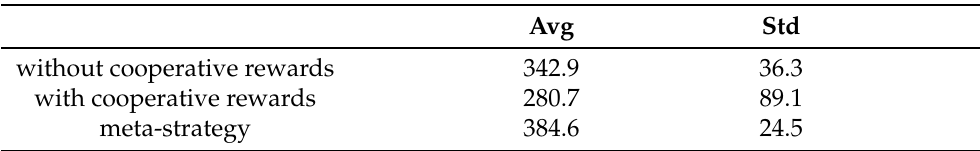
Figure 7. Total and cooperative rewards earned by agent with cooperative rewards (1 trial). Table 2. Number of forward in the last 1000